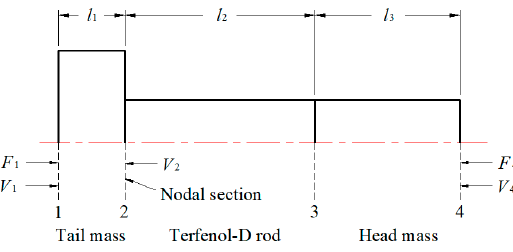
Figure 3. Simplified model of compound vibrator .